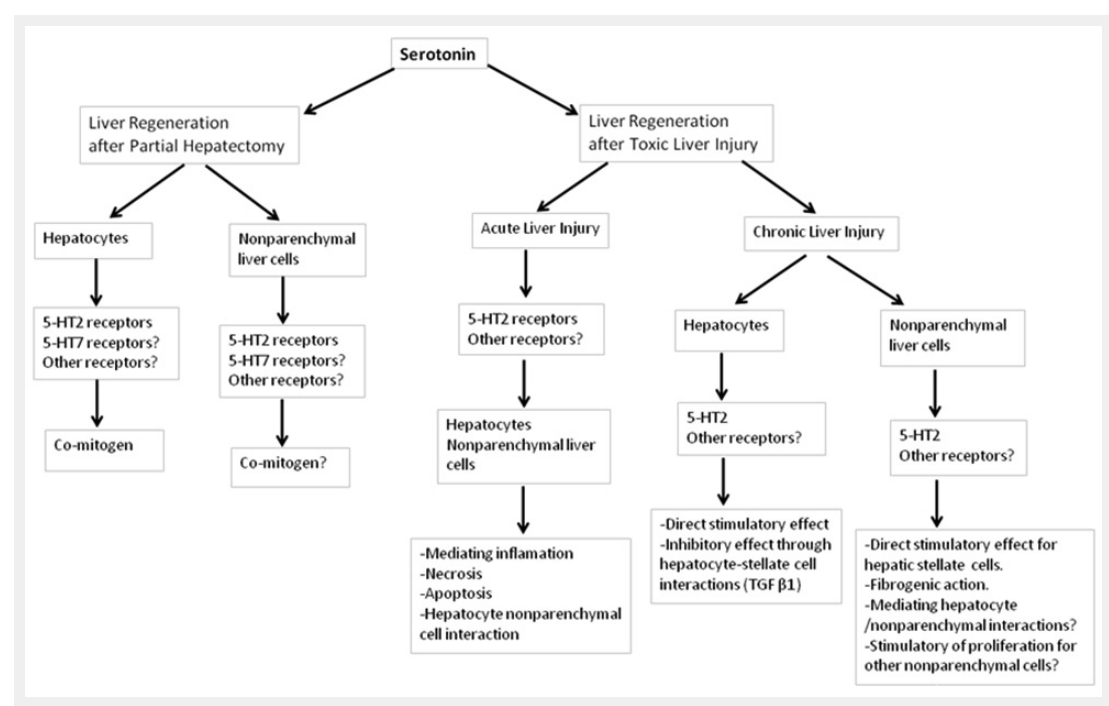
Figure 1 Schematic summary of the most important roles of serotonin in liver